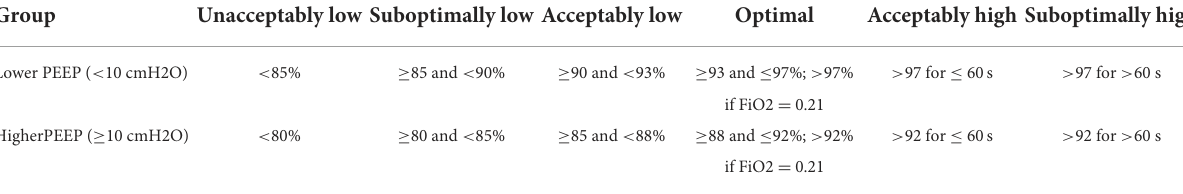
TABLE 1 SpO2 (Peripheral oxygen saturation)